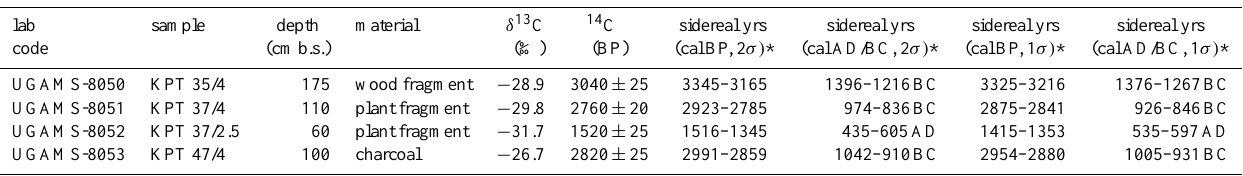
Table 2. Radiocarbon data from swale VI. All samples were measured in the Center for Applied Isotope Studies, University of Georgia, Athens (USA).